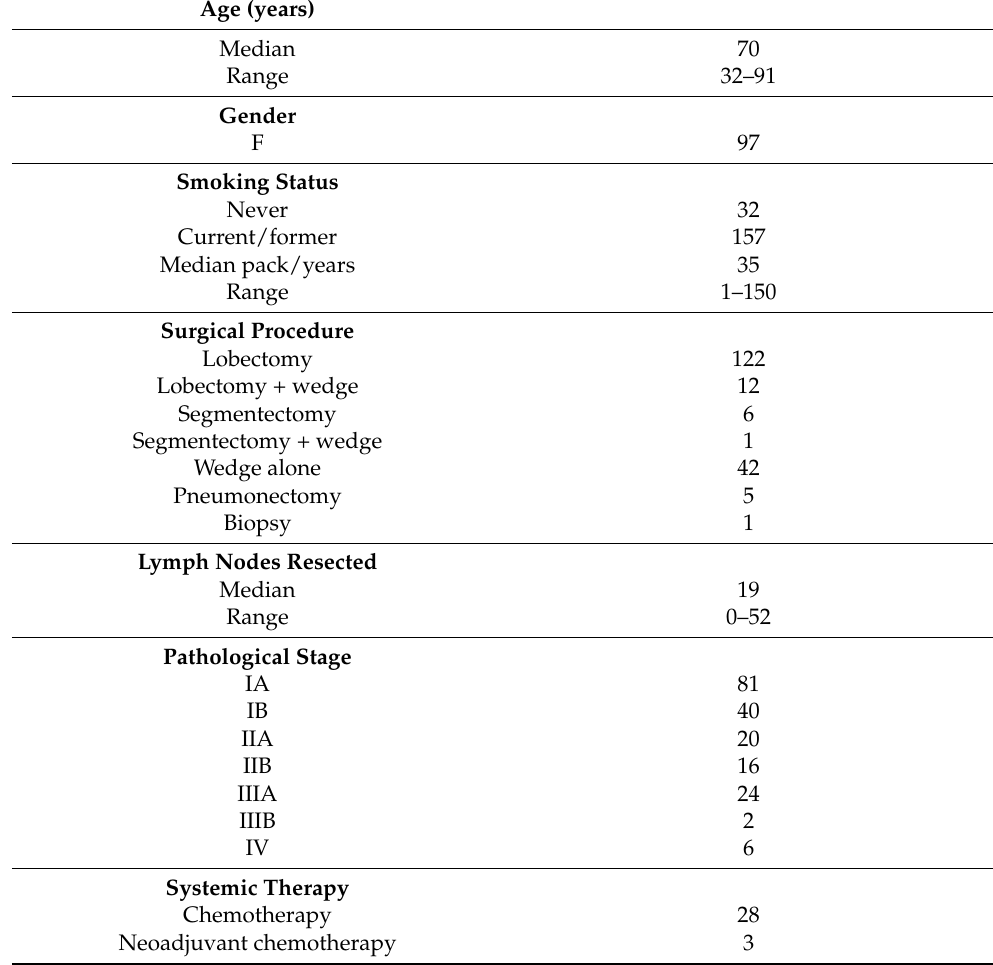
Table 1. Patient